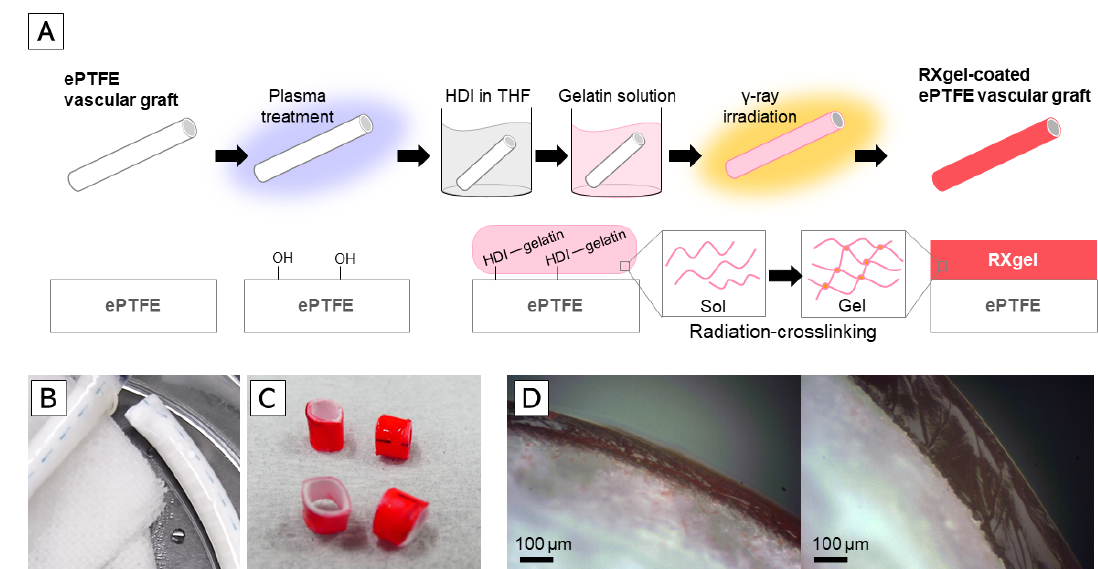
Figure 2. Radiation-crosslinked hydrogel (RXgel)-coated expanded polytetrafluoroethylene (ePTFE) vascular grafts based on radiation-crosslinking technique: ( A ) Schematic of fabrication process for RXgel-coated ePTFE vascular grafts; ( B ) Photograph of a typical RXgel-coated ePTFE vascular graft; ( C ) RXgel layer visualized using red food dye; ( D ) Cross-sectional images of representative RXgel-coated ePTFE vascular grafts of two different coating thicknesses.